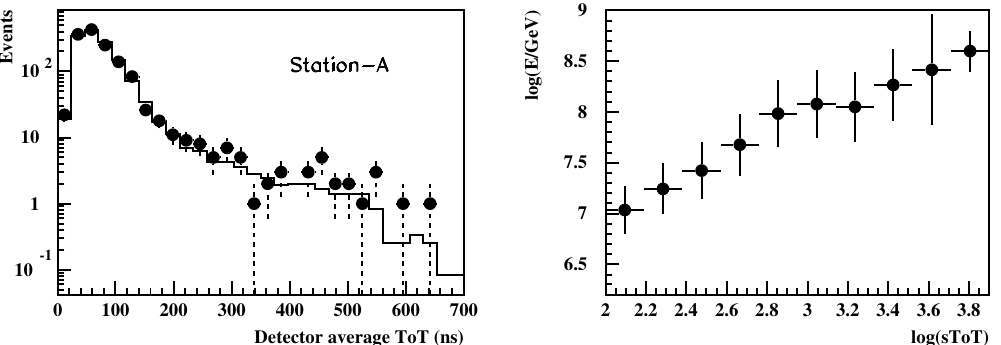
Figure 2. ( Left ) the distribution of the average ToT value of the HDM signals of station A for double station coincidence events. The points represent that data, while the histogram the MC prediction. ( Right ) The dependence of the sToT value on the primary energy as derived from the simulation for double station coincidence